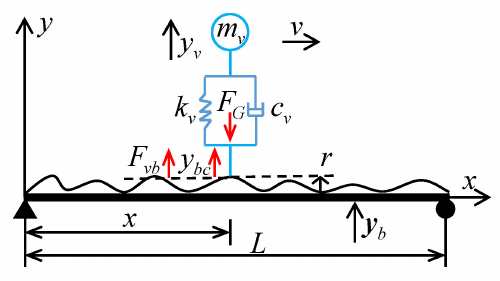
Figure 1. The VBI